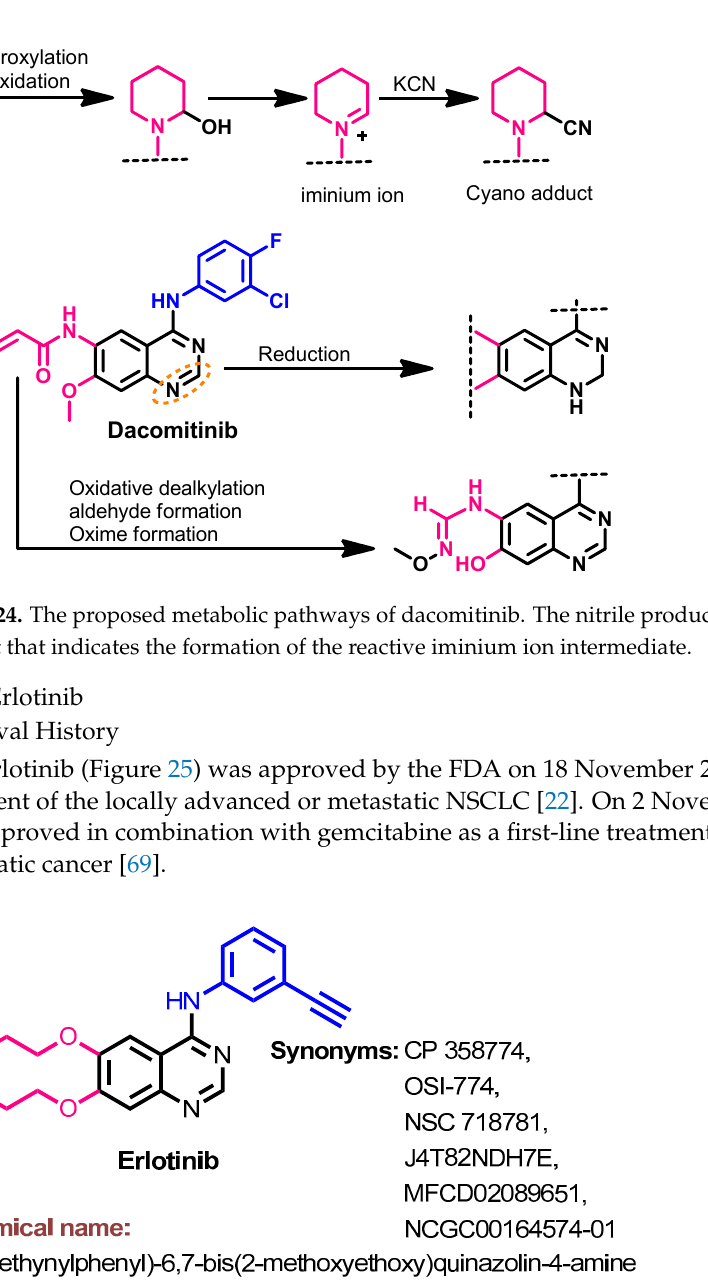
20 of 60 Figure 23. Binding modes of dacomitinib (shown as sticks) into T790M EGFR kinase domain (pdb: 4I24): ( A ) 3D binding mode, receptor shown as hydrogen bond surface; ( B ) 2D binding mode showing different types of binding interactions; the figure was generated using Discovery Studio Visualizer (V16.1.0.15350). Biological Activity Evaluation of the growth inhibitory activity of dacomitinib against a panel of 27 head and neck squamous cancer cell lines was performed by Ather et al. [67]. The results re- vealed a reduction in the growth of the cancer cells by at least 50% in 17 of the tested cell lines compared to erlotinib, which showed similar growth inhibition in 7 cell lines.